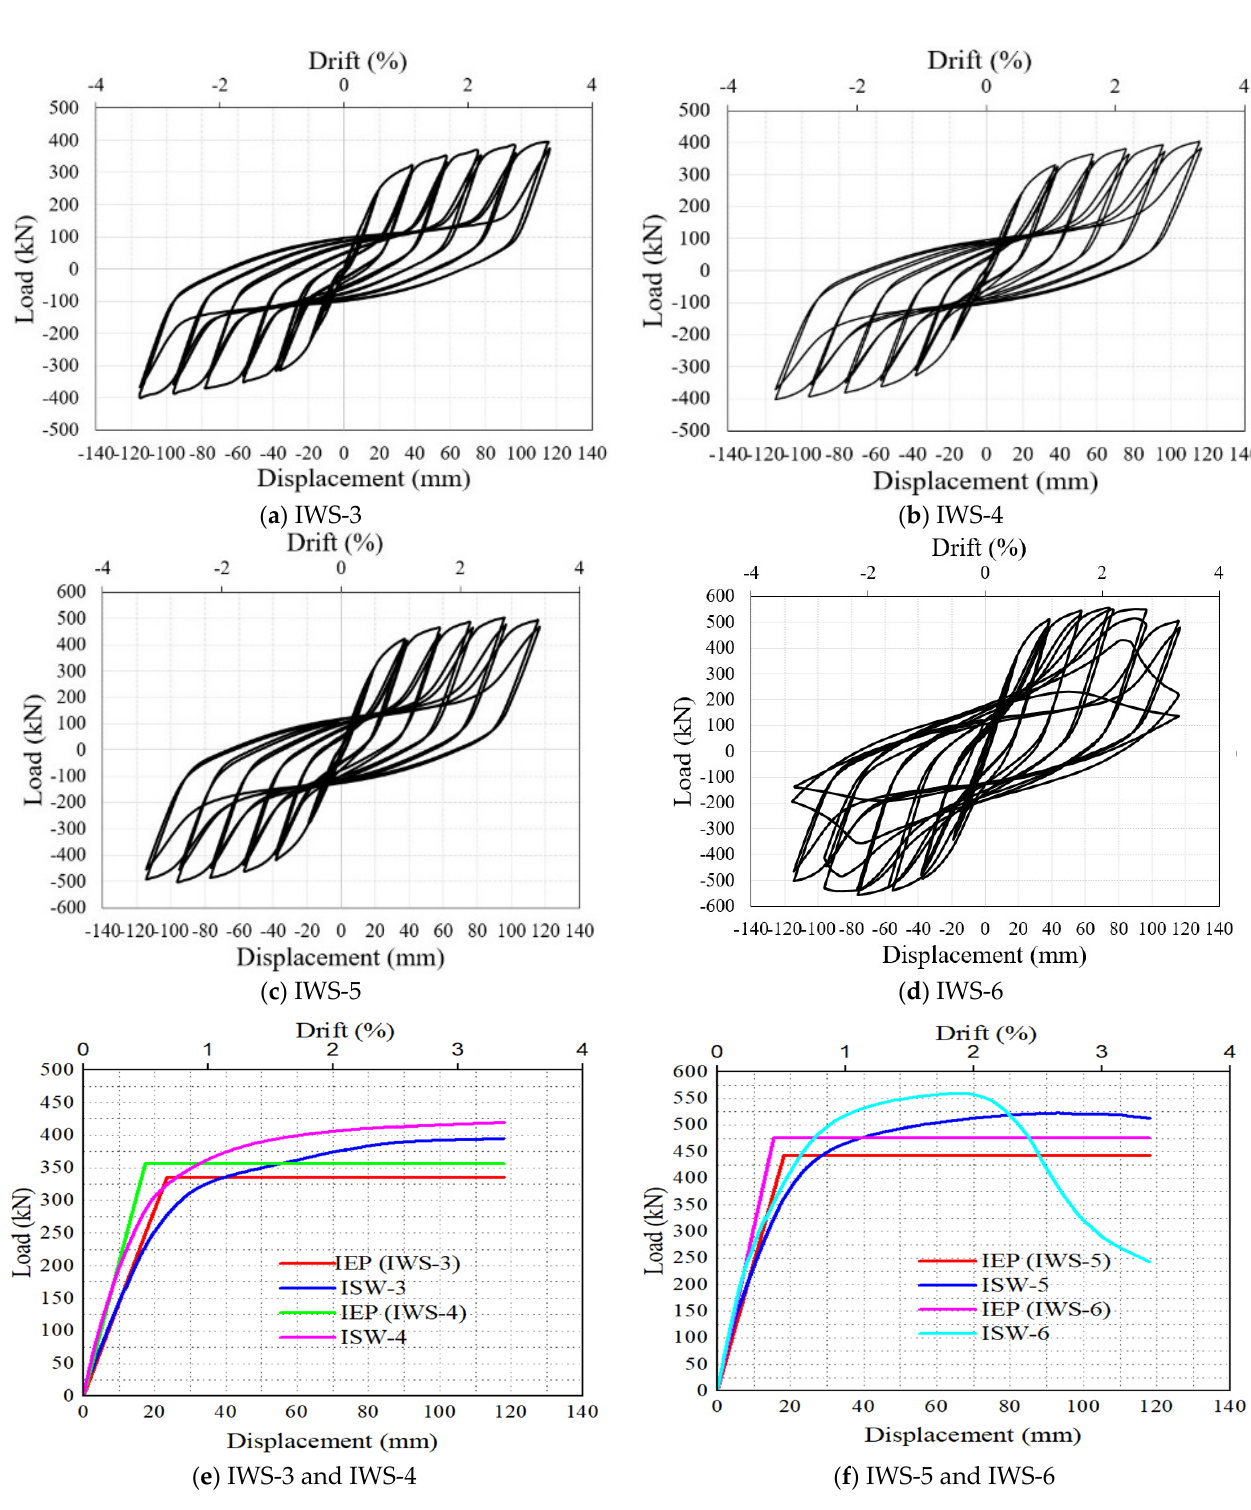
Figure 19. Hysteresis, pushover, and IEP response of the FE models.